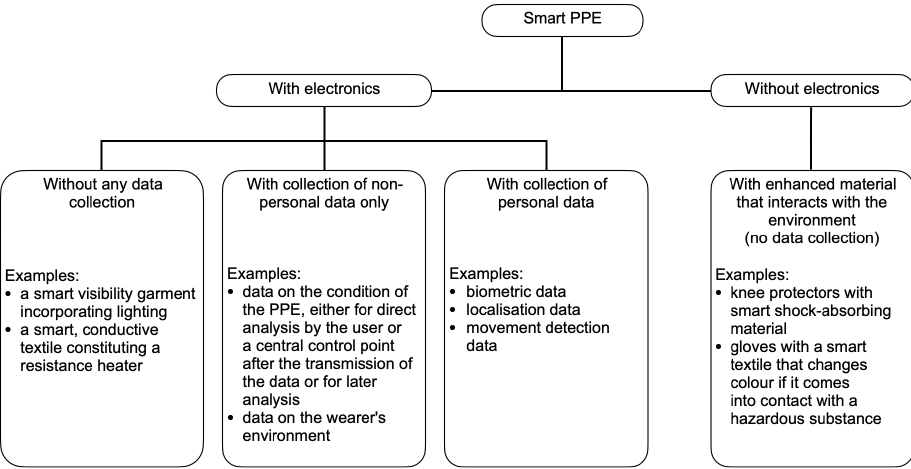
Figure 1. A proposal to classify a smart PPE, according to composition and data collection capabilities, as described in